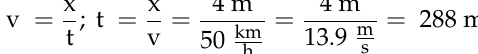
Figure 6. Short Lora transmission time diagram.